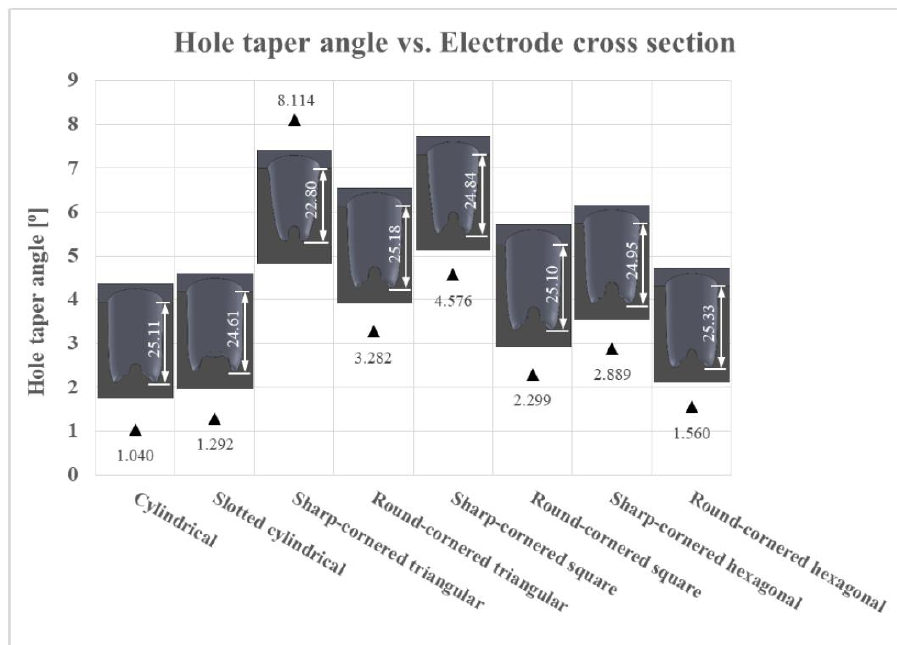
Figure 10. The hole taper angle values in relation with the different electrode cross sections (the dimensions are in mm).